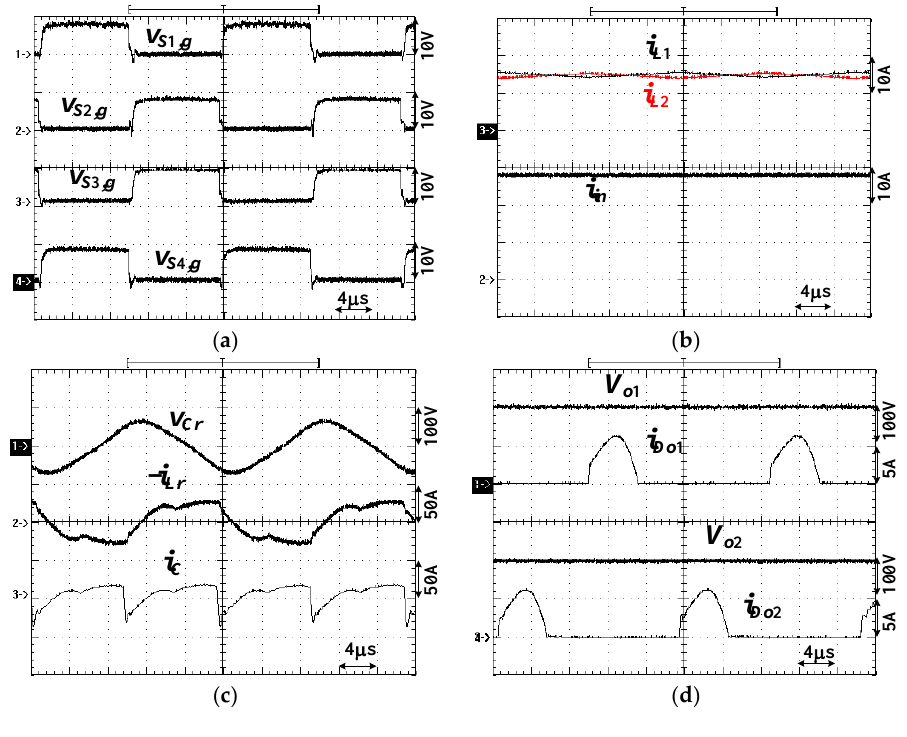
Figure 6. Test waveforms at V in = 20 V and rated power: ( a ) v S 1 , g ~v S 4 , g ; ( b ) i L 1 , i L 2 , i in ; ( c ) v Cr , −i Lr , i C ; ( d ) i Do 1 , i Do 2 , V o 1 , V o 2 .